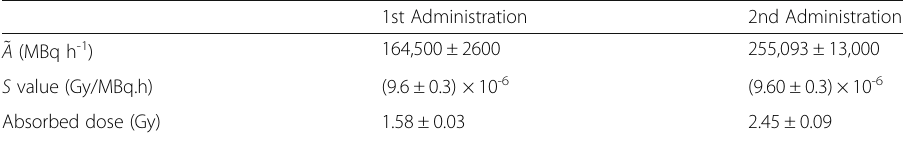
Table 1 Dosimetric parameters from whole-body data following both administations 1st Administration 2nd Administration ~ A (MBq h -1 ) 164,500 ± 2600 255,093 ± 13,000 S value